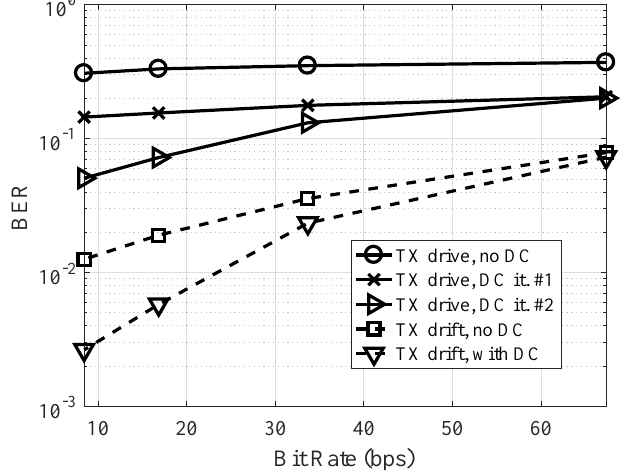
Figure 14. Measured bit error rate without Doppler compensation as a function of data rate for different ranges.